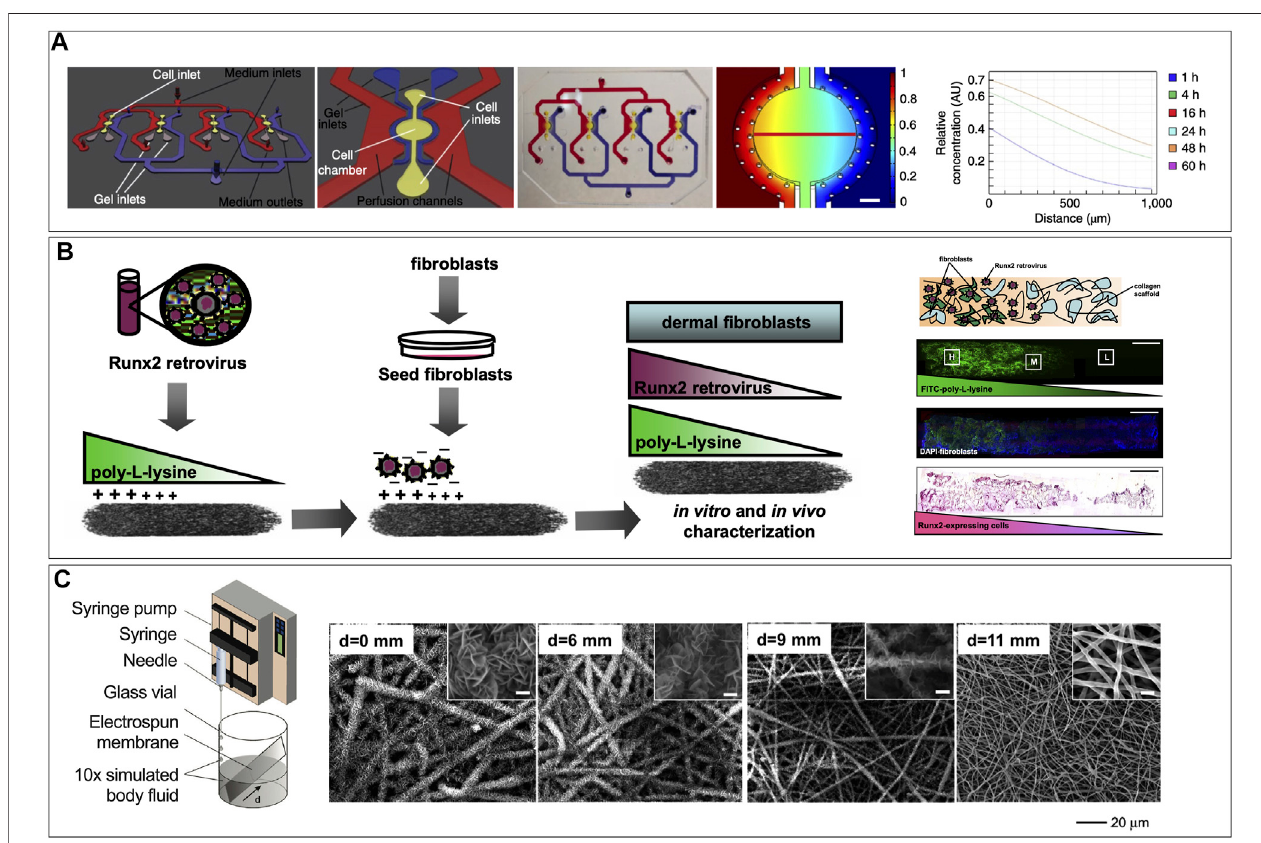
FIGURE6| Strategiesfor creating gradients that could beimplemented inmicrophysiological systems. (A) Engineered signaling centers forthe spatially controlled patterning of human pluripotent stem cells, showing schematic of the micro fl uidic device a single unit of the device, a picture of the PDMS micro fl uidic device fi lled with colored ink in the distinct compartments, and computational simulation of the diffusion of a reference molecule from the source side of the cell chamber after 48 h of perfusion. [Reproduced from (Manfrin et al., 2019) with permission]. (B) Schematic representation of scaffold-mediated spatially graded gene delivery strategy implemented to create a spatial distribution of Runx2 retrovirus within 3D matrices. The proximal portion of collagen scaffolds was coated with PLL before incubation in retroviral supernatant and fi broblast seeding. Representation of a fi broblast-seeded construct containing spatial patterns of noncovalently immobilized retrovirus, showing distribution of Runx2 retrovirus (R2RV) created by partially coating the proximal portion (left side) of collagen scaffolds with PLL at a dipping speed of 170 μ m/s beforeincubation inretroviralsupernatant and cellseeding. Confocal microscopy images demonstratingagraded distributionofFITC-labeled PLL(green) (B) and FITC- labeled PLL gradient colocalized with uniformly distributed cell nuclei (DAPI, blue), and immunohistochemical staining for eGFP (pink) counterstained with hematoxylin (blue) revealed elevated eGFP expression on the proximal scaffold portion coated with PLL-R2RV. [Reproduced from (Phillips et al., 2008. Copyright (2008) National Academy of Sciences, United States) with permission]. (C) Nano fi ber scaffolds with gradations in mineral content for mimicking the enthesis using a graded coating of calciumphosphateonanonwovenmatofelectrospunnano fi bersbysubmergingin10×concentratedsimulatedbody fl uidaddedataconstantratetolinearlyreducethe deposition time from the bottom to the top end of the substrate (d refers to the distance from the bottom edge of the substrate) (Left). SEM images of graded calcium phosphate coatings on the PLGA nano fi bers from different regions, with d = 0 mm representing the longest exposure to SBF and d = 11 mm representing the shortest exposure to SBF [Reproduced from (Li et al., 2009) with